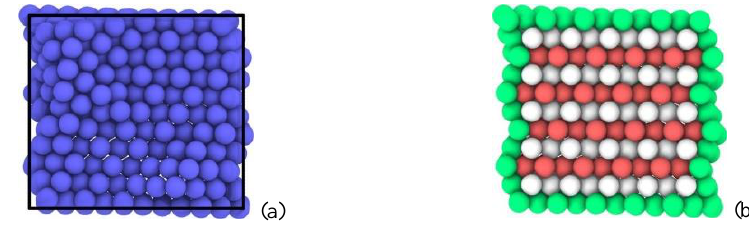
Fig. 3. (a) View of the perfect nanorod cut by a plane perpendicular to the Y axis. Green shows surface atoms, white – the atoms in the volume. (b) View of the amorphized nanorod cut by a plane perpendicular to the Y axis. Green shows surface atoms, white shows the atoms in the volume forming the face-centered cubic structure; red shows the atoms forming the FCCP structure.